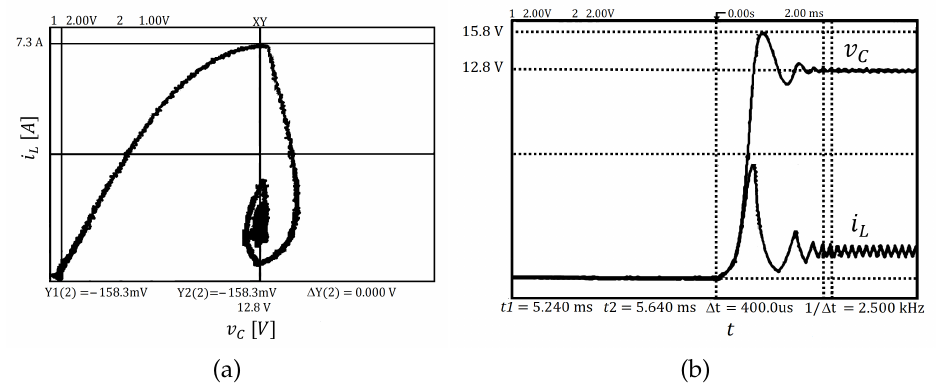
Figure 27. Experimental validation of voltage control using the constant hysteresis control with low value, e.g., ξ = 0.05 V, and required voltage is V ref = 12 V : ( a ) phase portrait and ( b ) time